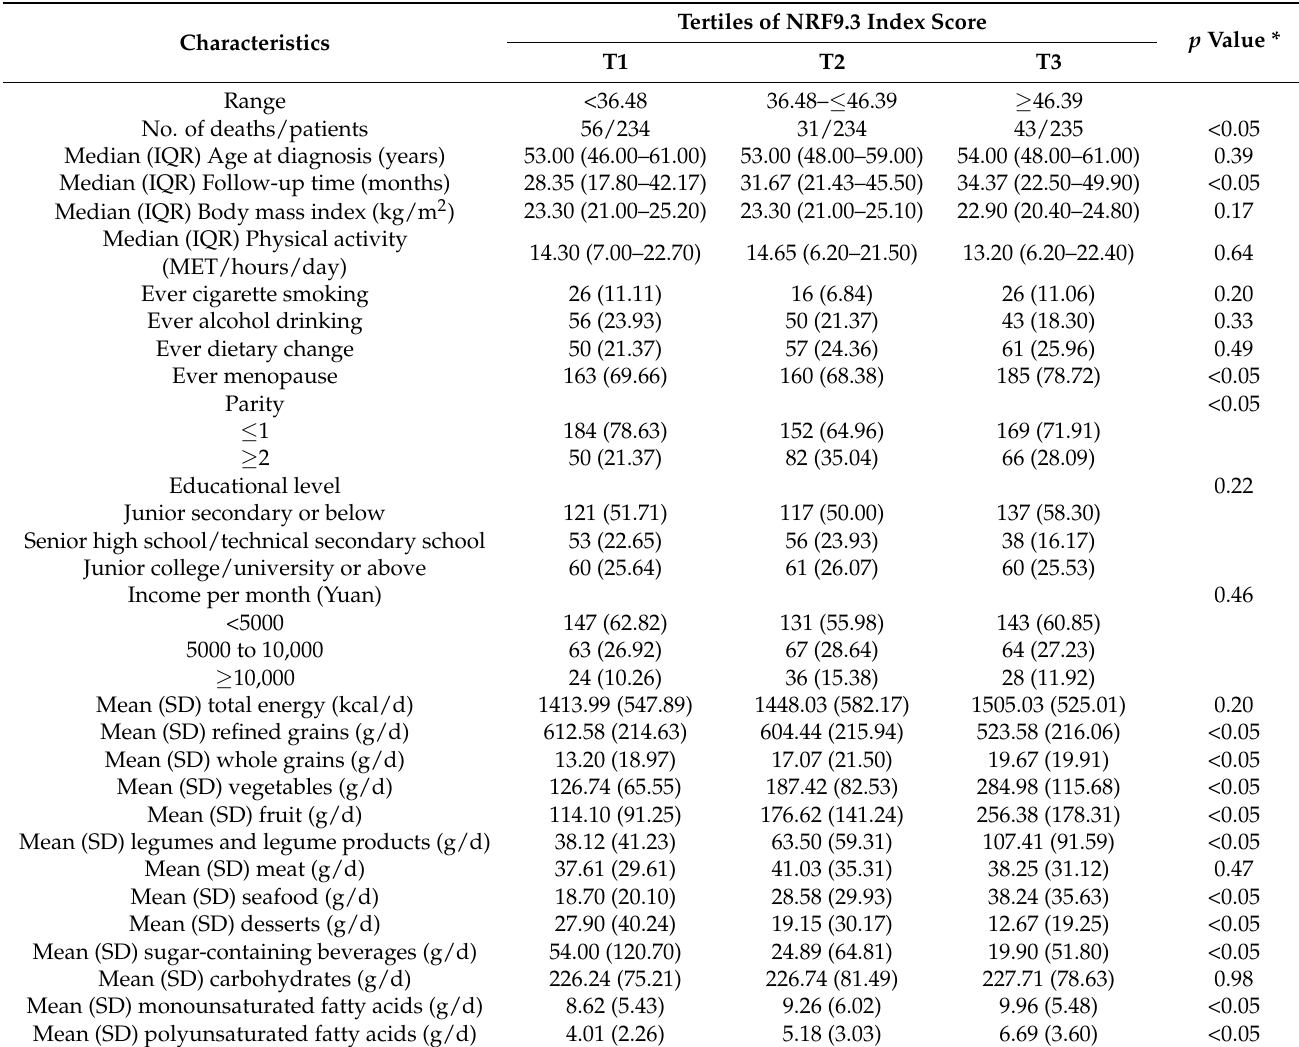
Table 1. Baseline characteristics of females with ovarian cancer by tertiles of NRF9.3 index score (N =